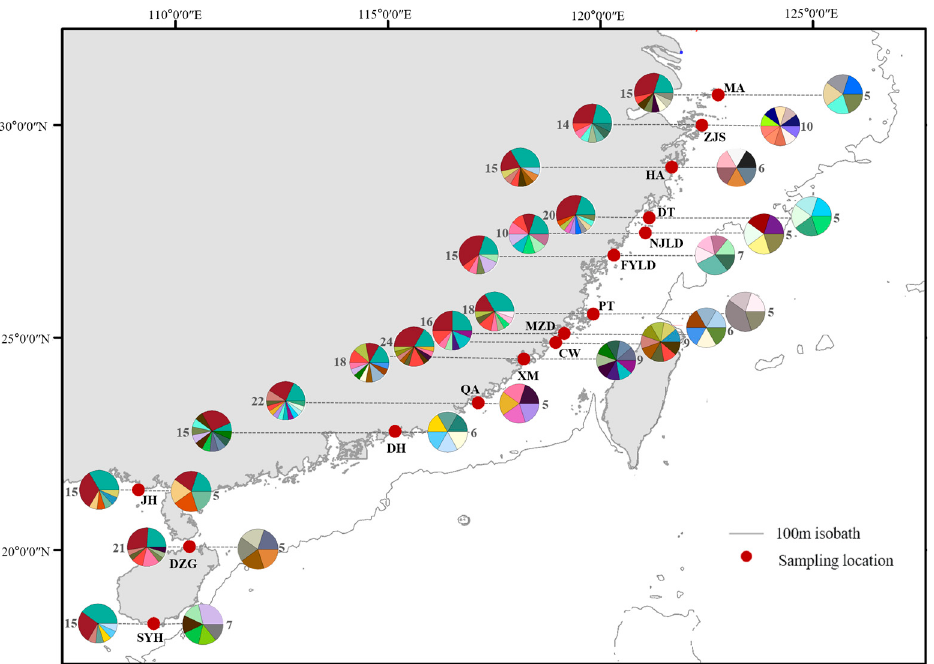
Figure 2. Haplotype map for horn-eyed ghost crab COI ( left ) and D-loop ( right ). Numbers represented the number of sequences used for analysis. Different colors represented different haplotypes.